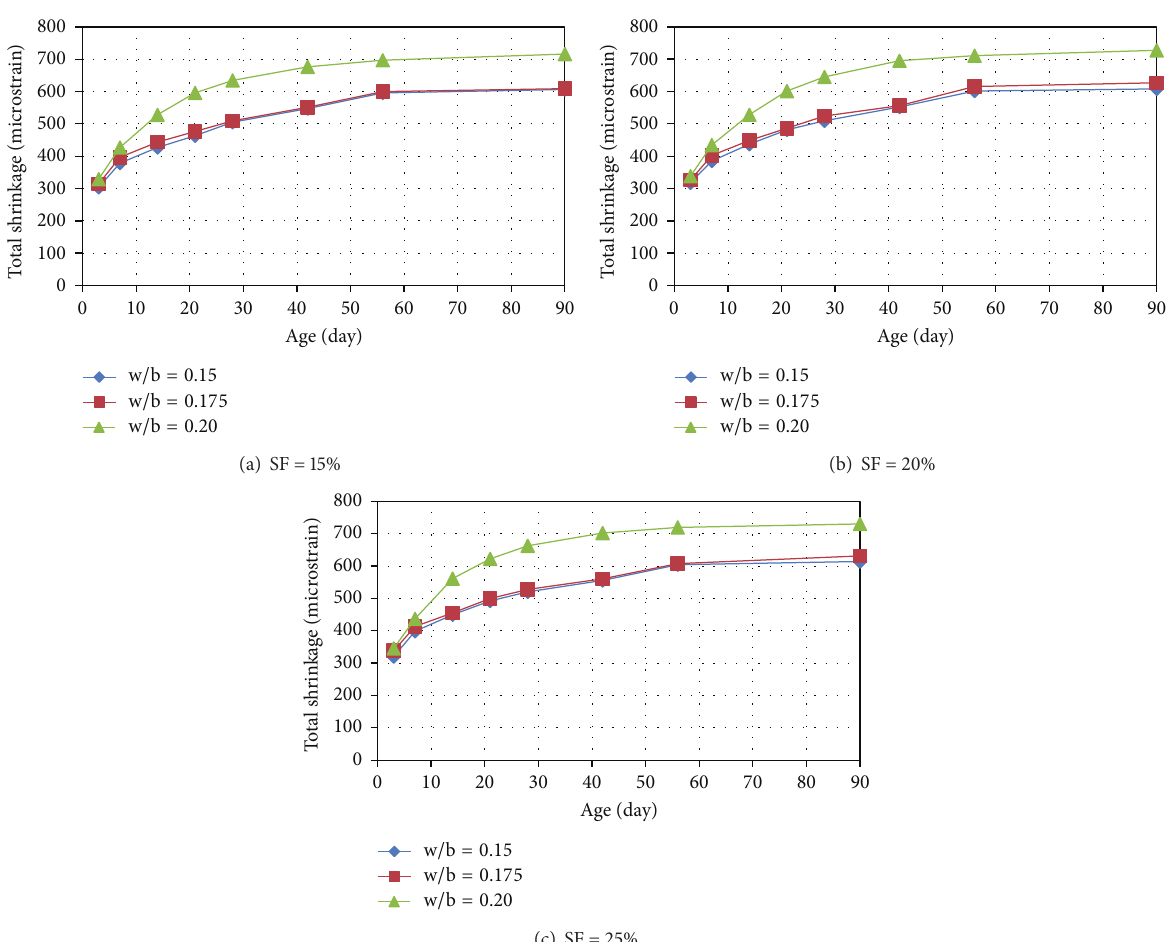
Figure 4: Variation of total shrinkage of RPC mixtures (having cement content of 1200kg/m 3 ) with